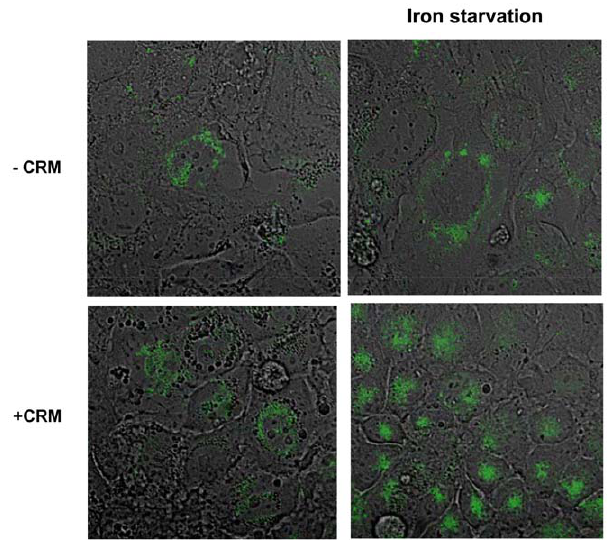
Figure 6. Proinflammatory cytokines promote Tf uptake by CaCo-2 cells. The effect of CRM (lower panel) and iron starvation (100 m M Desferal, right panel) on tagged (Alexa 594) Tf uptake by Caco- 2 cells as imaged by confocal microscopy ( 6 25).